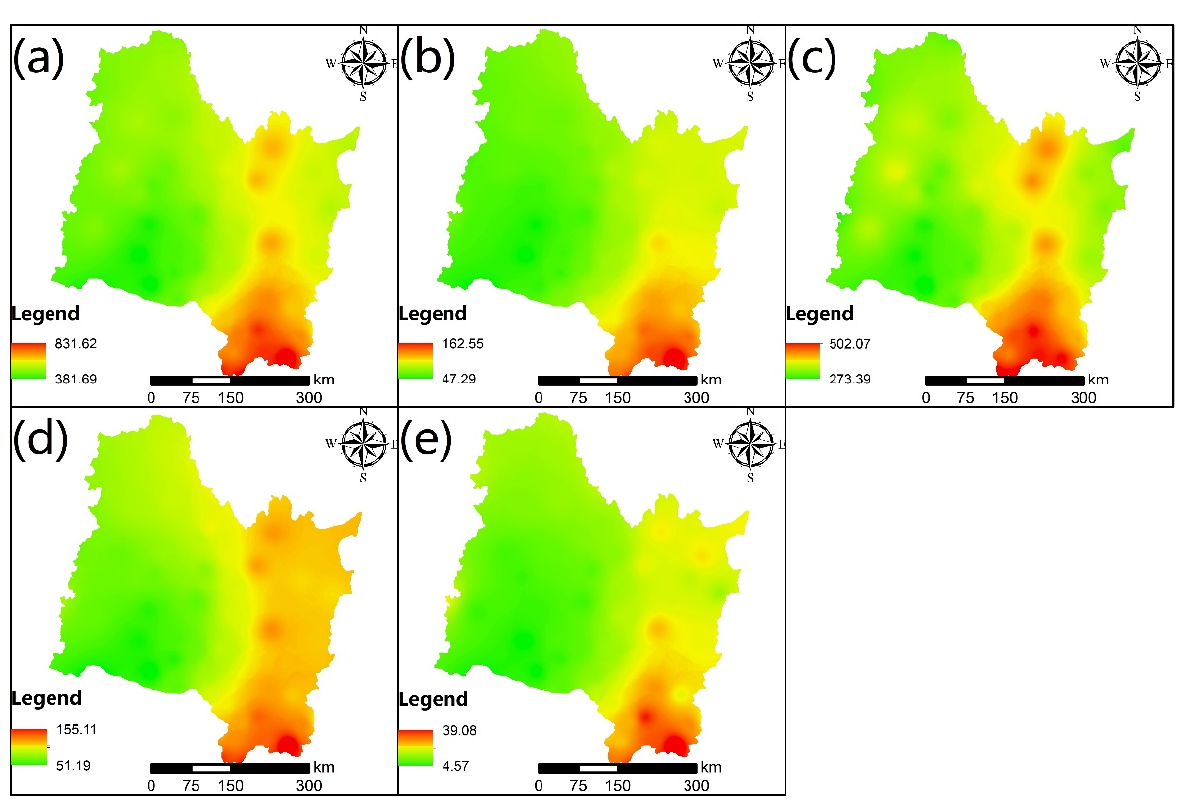
Figure 4. Average yearly and seasonal precipitation distribution within the SHRB. The ( a – e ) represent the average yearly, spring, summer, autumn, and winter precipitation, respectively.